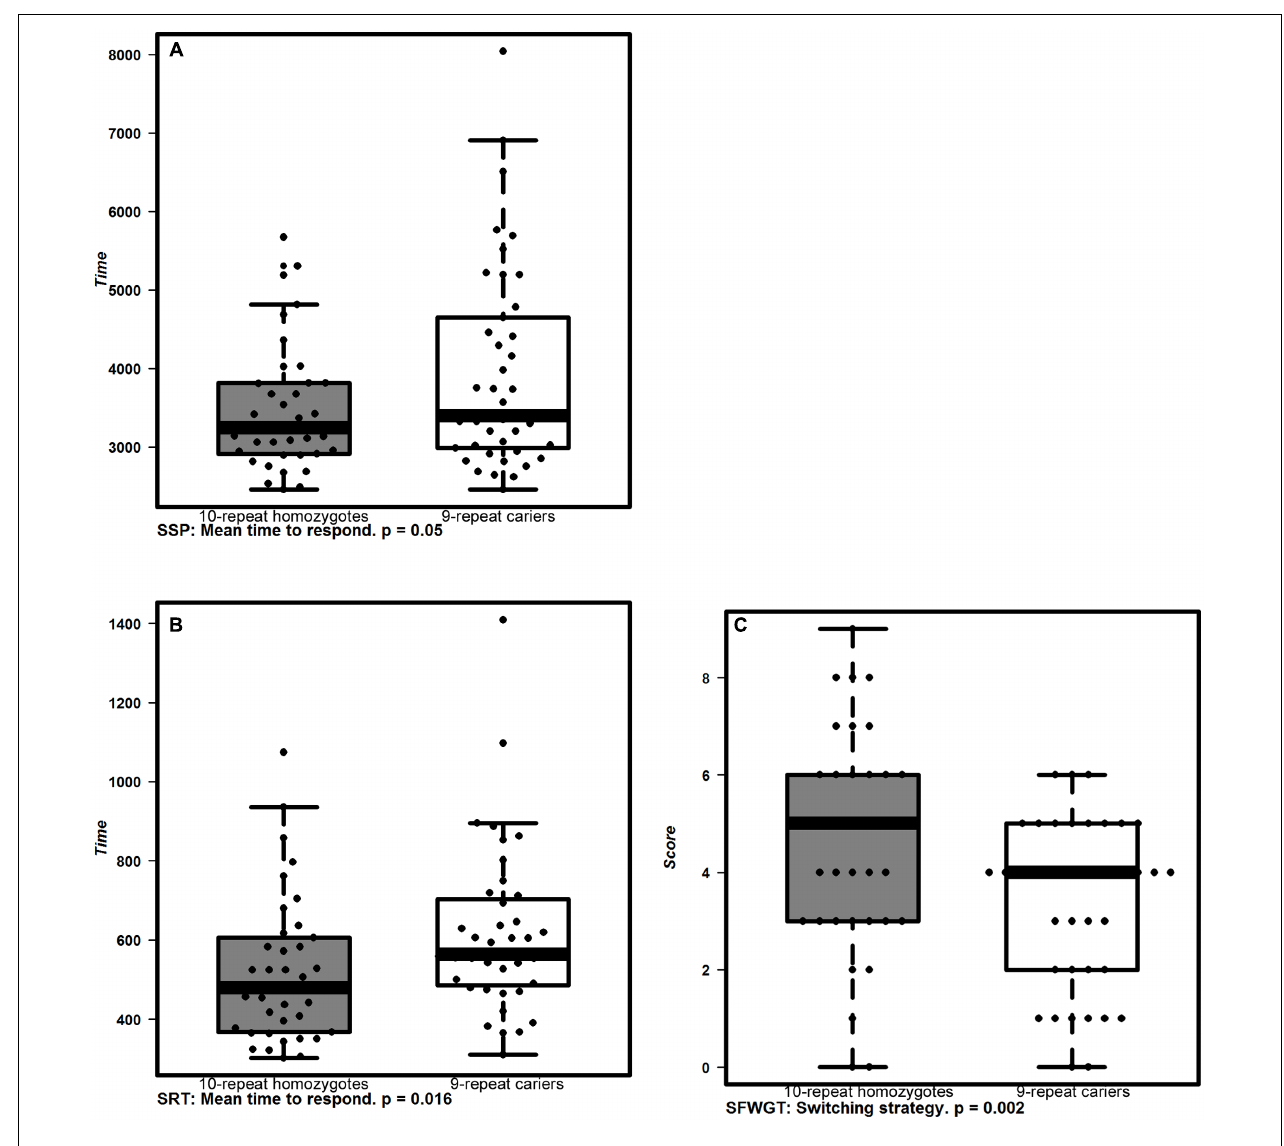
FIGURE 1 | Cognitive performance associated with VNTR-DAT1 polymorphisms. Box plots represent the cognitive performance of allelic groups of VNTR-DAT1 polymorphism. 10-repeat homozygotes (gray boxes) displayed shorter response times in CANTAB (A) SSP ( p < 0.05; two way ANOVA) and (B) SRT tasks ( p < 0.016; two way ANOVA), and better mental flexibility measured by (C) SFWGT (Switching strategy; p < 0.016; two way ANOVA) than 9-repeat carriers (white boxes). The boxplots show the median and interquartile range. Dots indicate individual